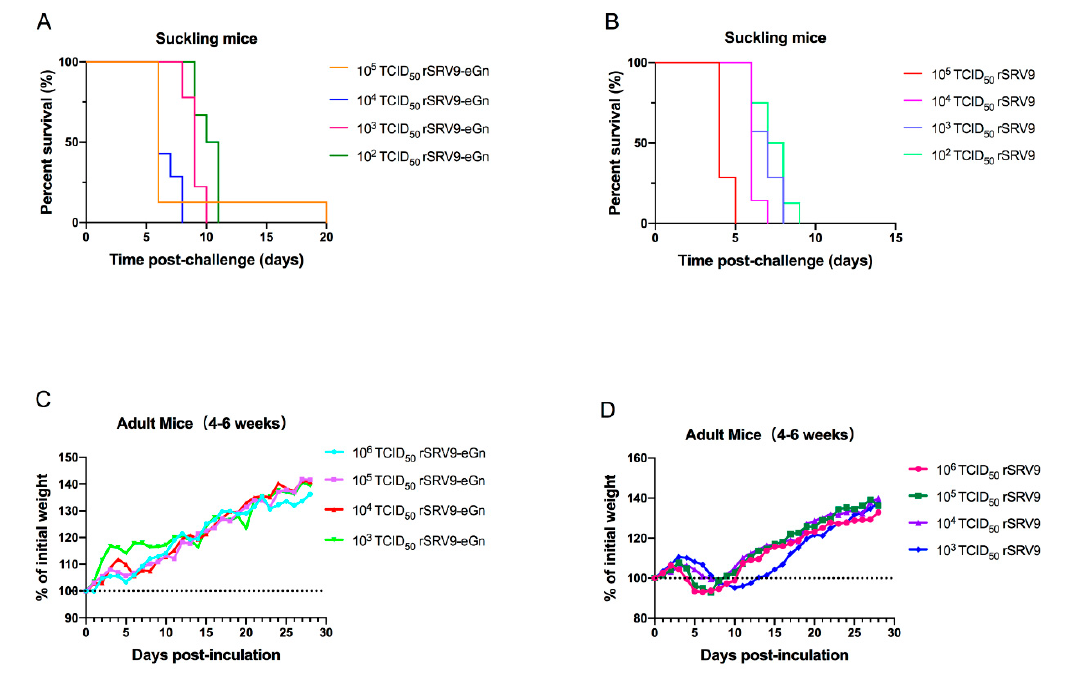
Figure 6. Pathogenicity evaluation of the recombinant rSRV9-eGn virus. Seven-day-old ICR suckling mice were inoculated intracerebrally with 50 µ L of solution containing 10 5 to 10 2 TCID 50 recombinant viruses ( A ) or control vector viruses ( B ), and the survival of the suckling mice was monitored daily for 21 days. Groups containing eight 4- to 6-week-old female ICR mice were inoculated intracerebrally with 50 µ L of solution containing 10 6 to 10 3 TCID 50 recombinant viruses ( C ) or control vector viruses ( D ), and weight changes were monitored daily for 21 days. Body weight changes in the indicated groups are shown as percentages of the body weight at day 0, which was set as 100.